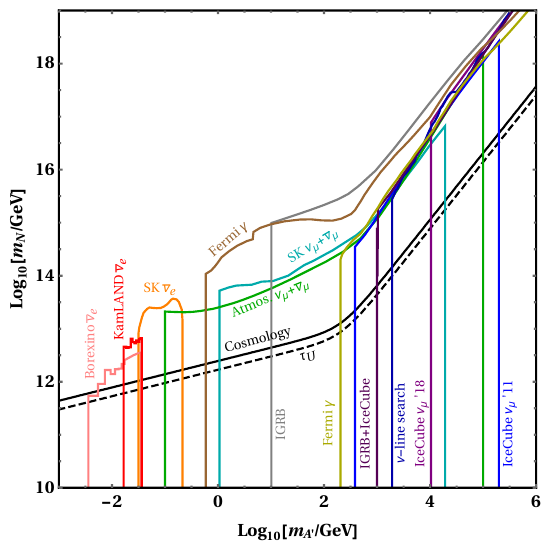
Figure 5 . Lower bounds on the heavy sterile neutrino mass, m N , from constraints on the lifetime of DM which decays as A 0 → ν ¯ ν and A 0 → ‘ + ‘ − . Limits on the former are shown in figure 4, while the brown, mustard and grey lines correspond to constraints on the latter from refs. [45, 47, 48], respectively. Here we assume that the couplings are of order unity and m χ = m A 0 , and that the DM couples universally to the three